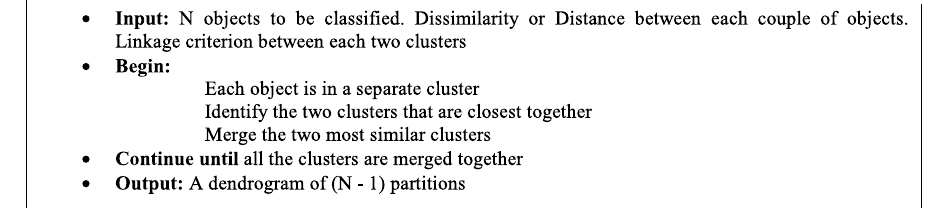
Fig. 1. Hierarchical clustering algorithm